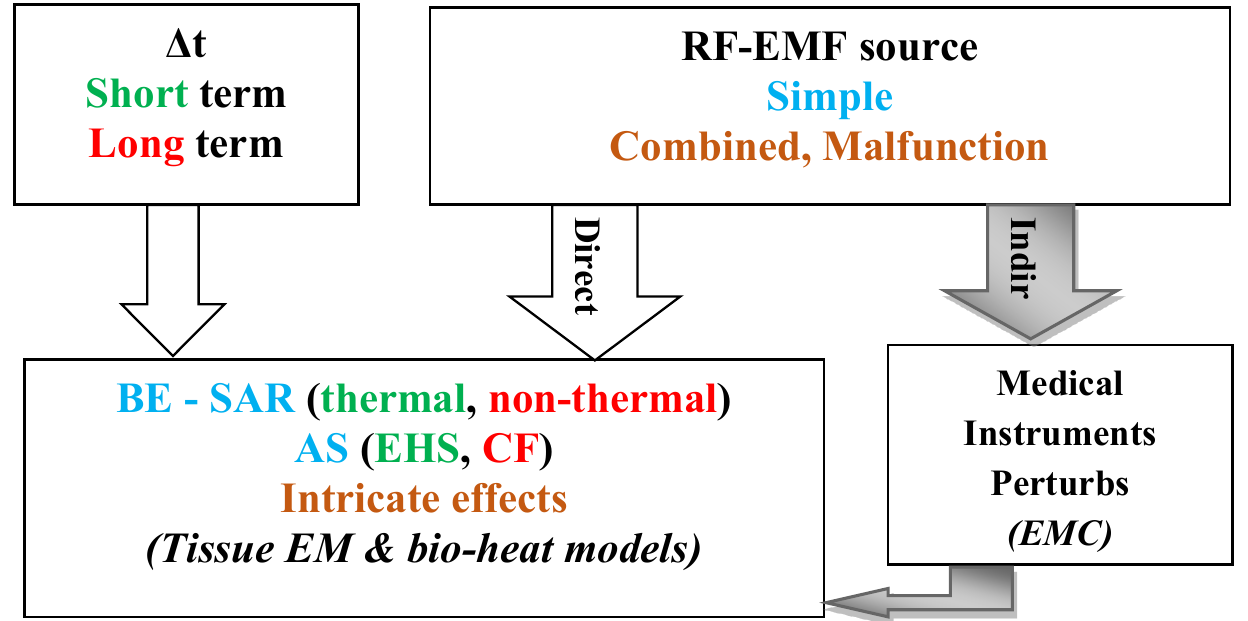
Figure 3. Schematic illustration of different categories of sources, exposure terms, effects and evaluation tools.